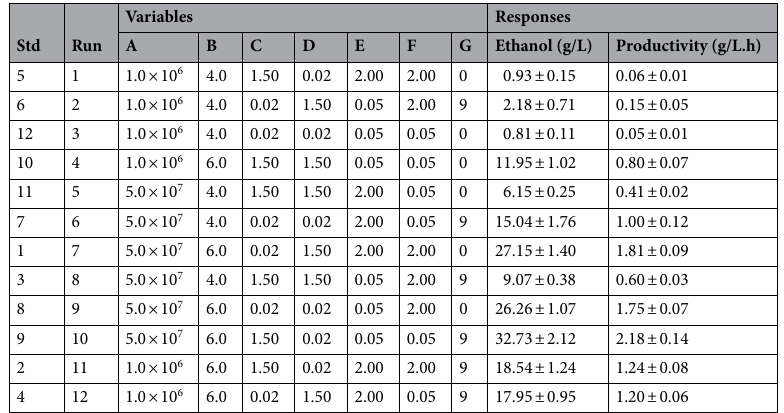
Table 4. Plackett–Burman design matrix for the screening of variable effects on ethanol production from PWH using S. cerevisiae HG1.1.